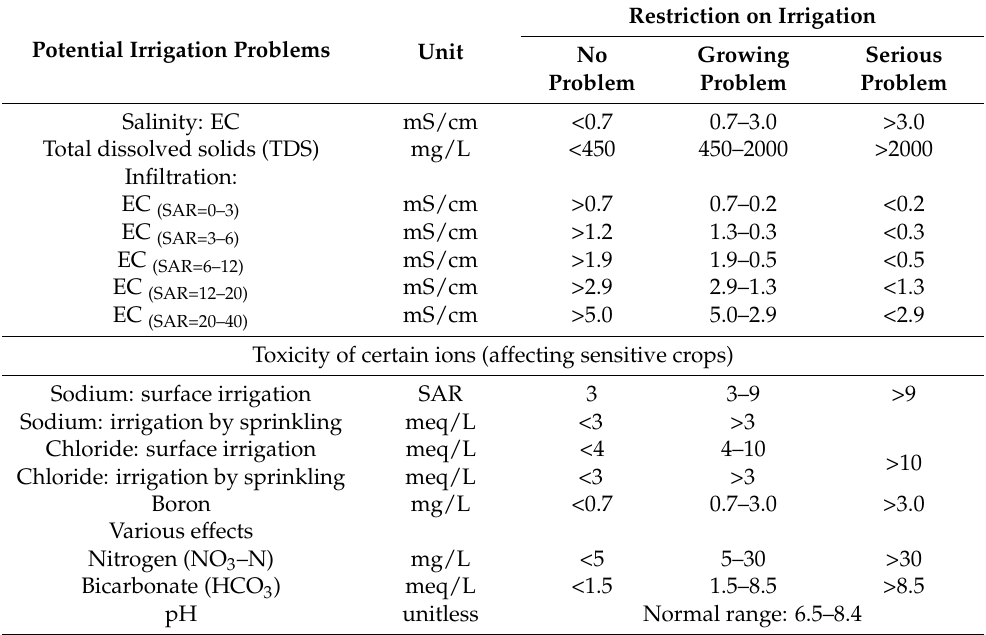
Table 1. Guidelines for the interpretation of irrigation water quality according to FAO [28] (EC: electrical conductivity, SAR: sodium absorption